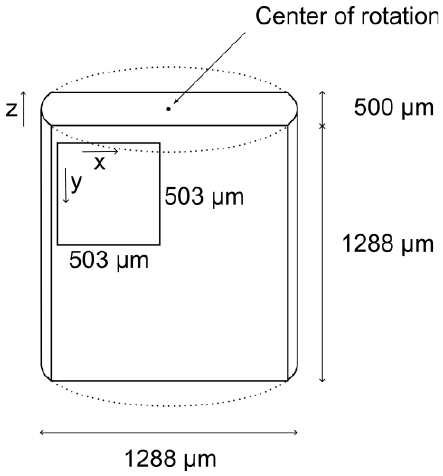
Figure 6. Size of the reconstructed X-ray computed tomography image and the cropped area shown in Figure 5.